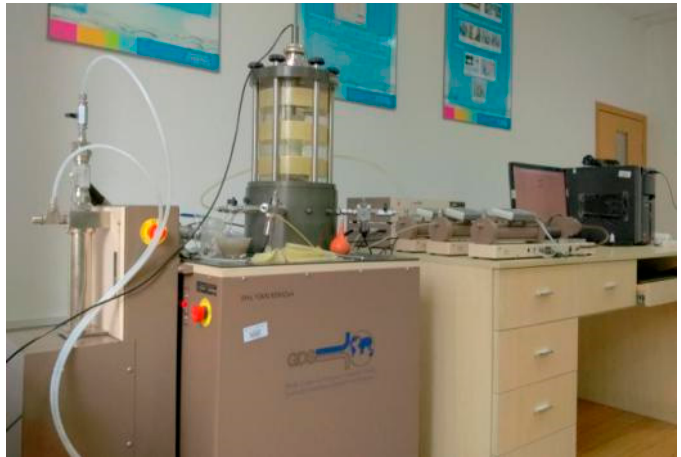
Figure 3. Dynamic triaxial test machine.